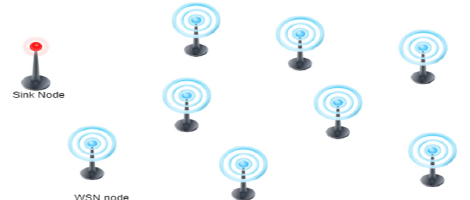
Figure 1. WSN structure.